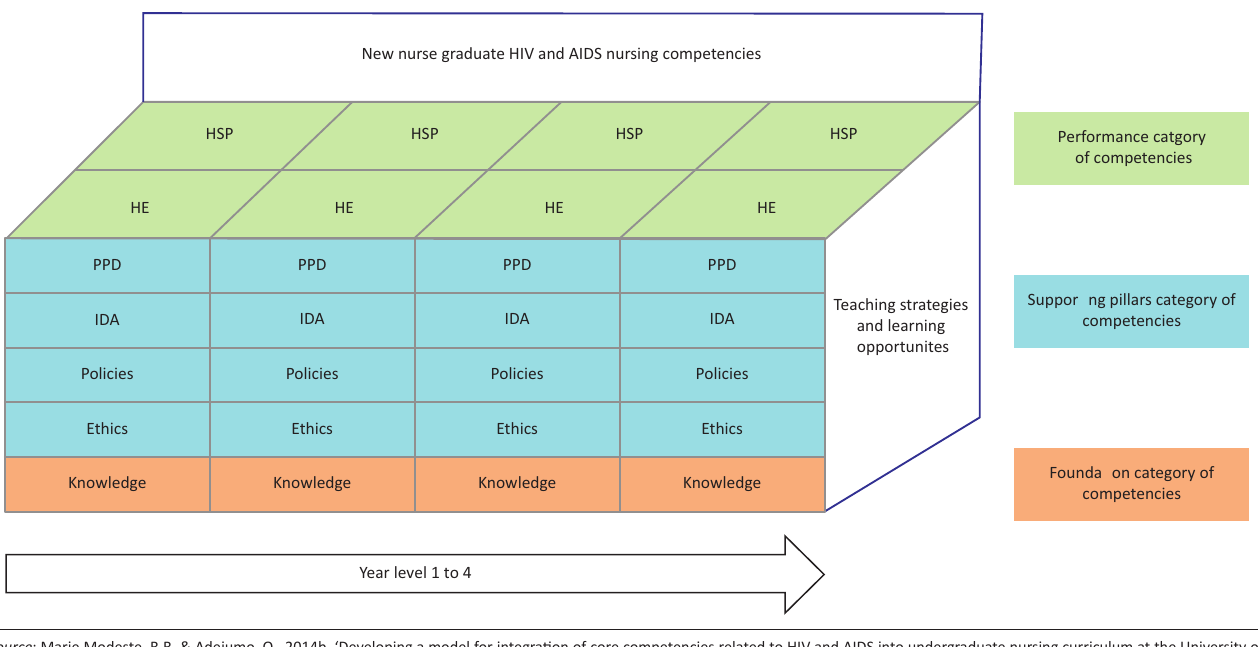
FIGURE 1: Vertical and horizontal integration of HIV and AIDS nursing competencies into a four-year nursing